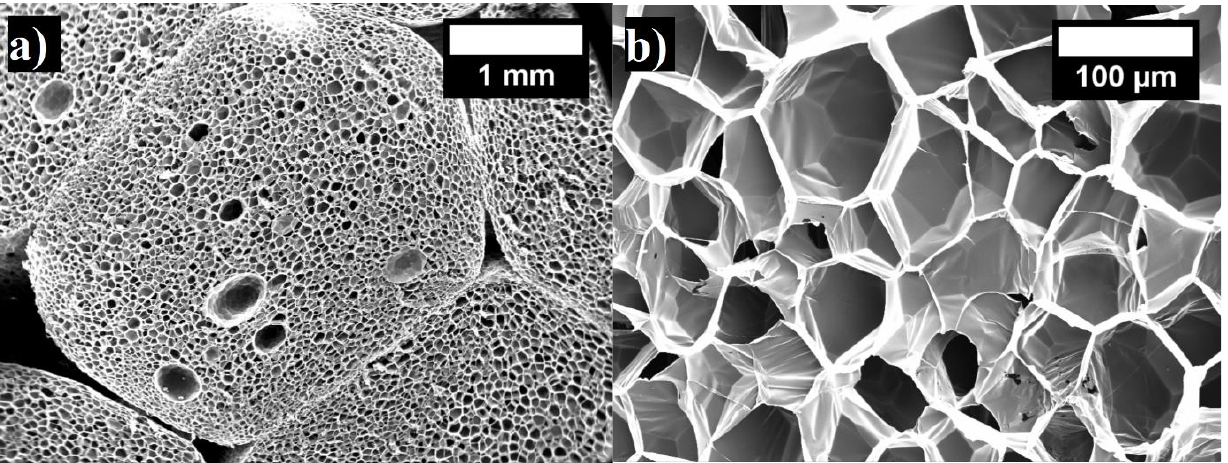
Figure 1. The presented structure of EPS at 17 kg/m 3 density: ( a ) microstructure of pores (magnification ×80); ( b ) microstructure of cells (magnification ×800).